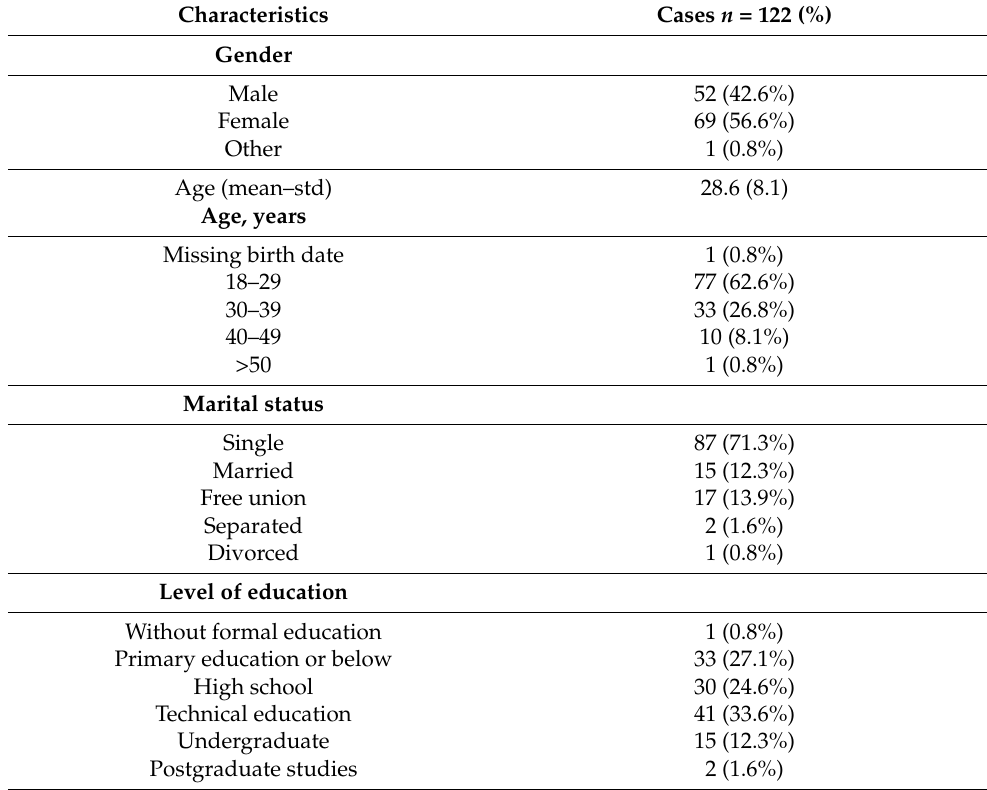
Table 1. Socio-demographic characteristics of Colombian CCS.